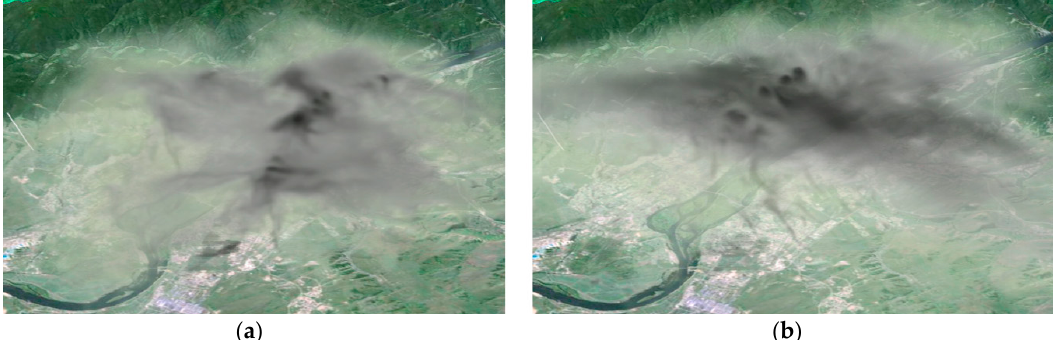
Figure 3. Snapshots of instantaneous CO concentration distribution at 1800 LT. ( a ) Summer; ( b ) winter (volume rendering). Atmosphere 2019 , 10 , x FOR PEER REVIEW